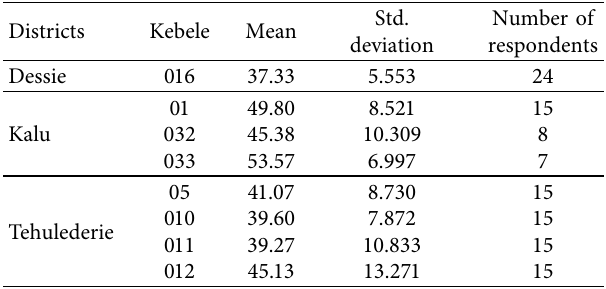
Table 1: Average age of respondents in Dessie, Kalu, and Tehu- lederie districts.